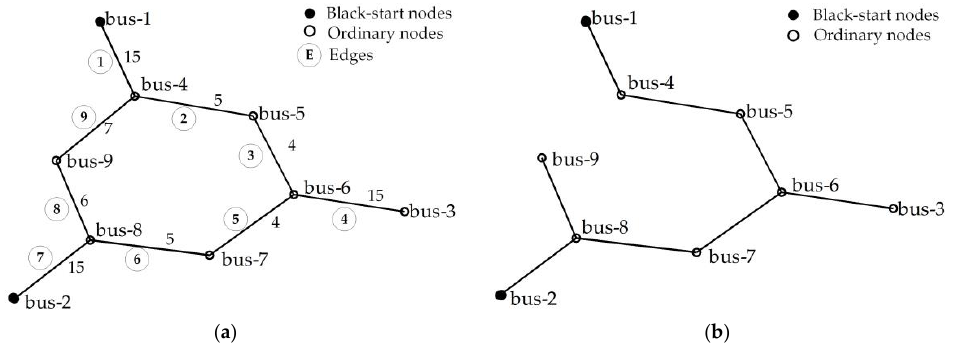
Figure 3. ( a ) The graph of IEEE 9-bus test system; and ( b ) the skeleton network.